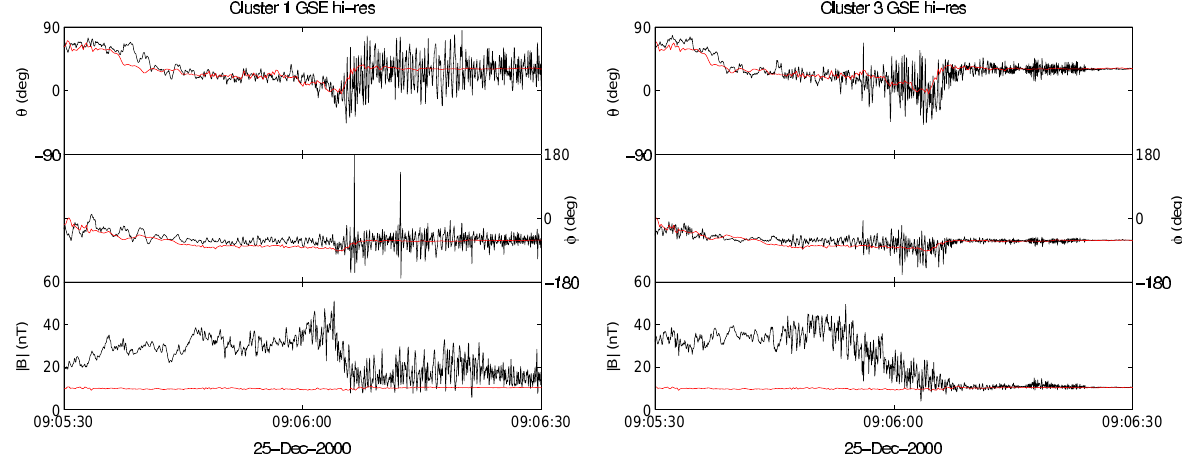
Fig. 8. (left) One minute of high resolution magnetic field data at Cluster 1 (black lines). Spin averaged data from Cluster 2 are superimposed in red, time shifted to align solar wind angle changes. (right) Cluster 3 data in the same